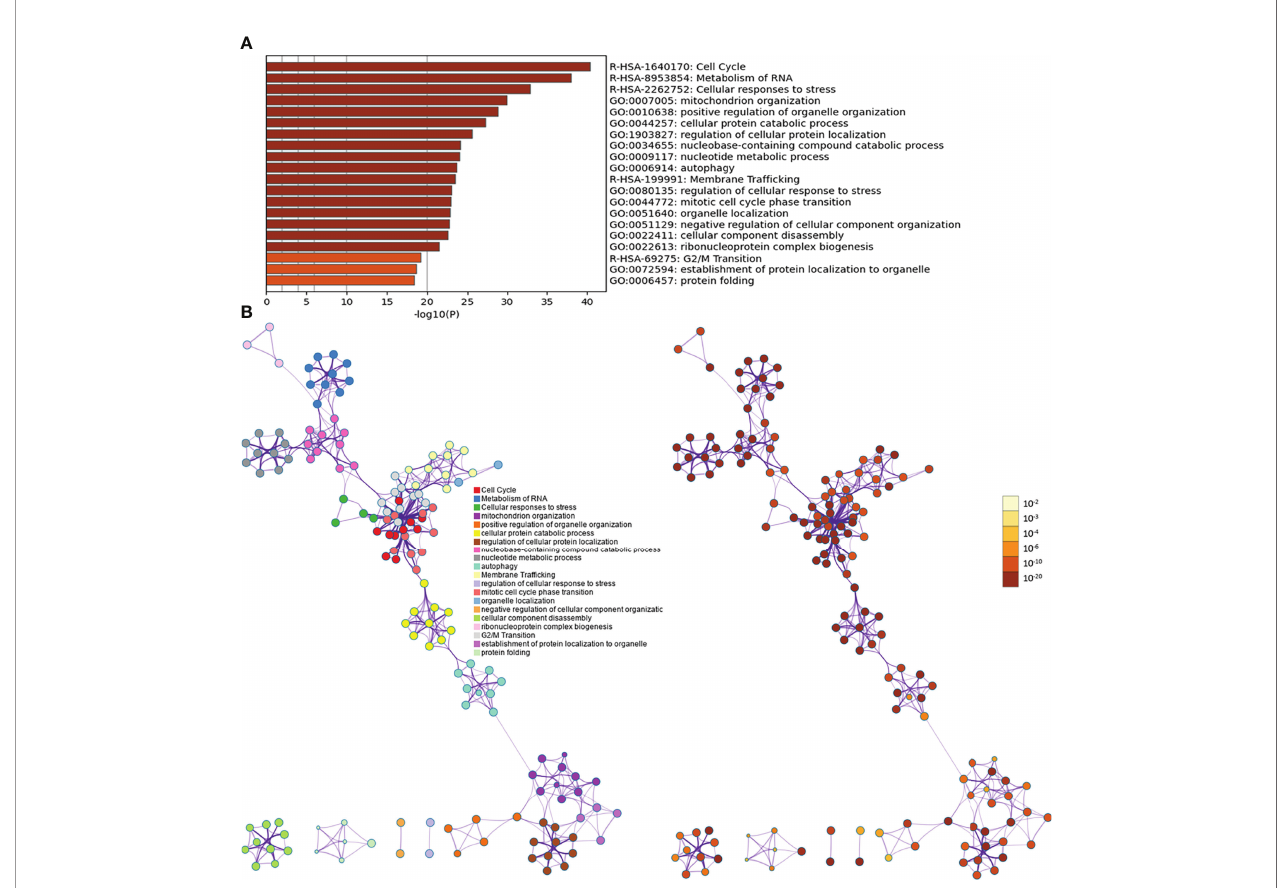
FIGURE 6 | Metascape results [ (A) Heatmap of top enrichment results; (B) PPI network colored by cluster and by P